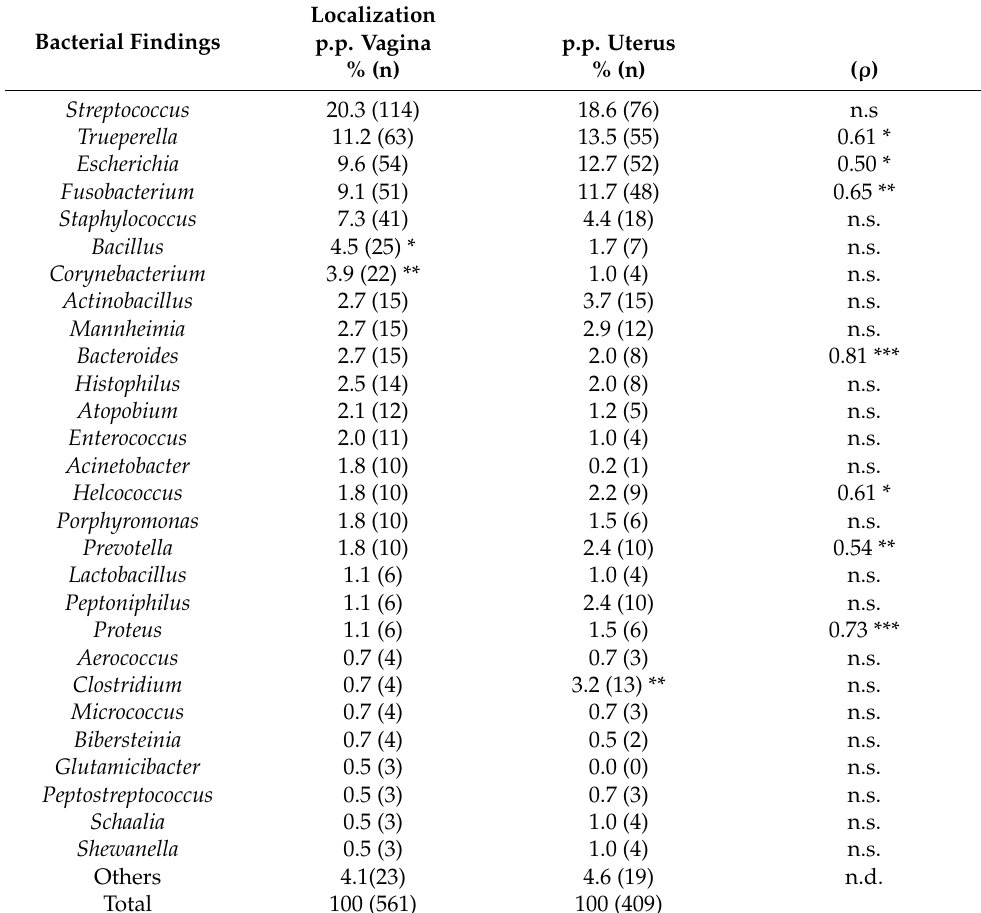
Table 4. Microbial core community of the vagina and uterus at genus level of 22 cows within 14 days after calving.